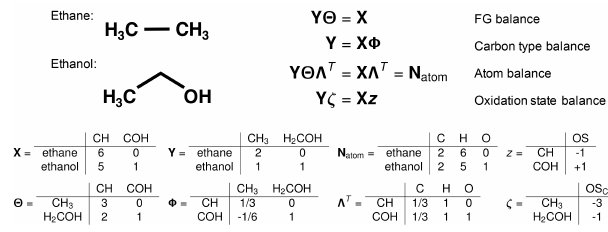
Figure 1. Illustration of carbon type and FG relationships for ethane and ethanol. The FG composition matrix ( X ), carbon type matrix ( Y ), and atom composition matrix ( A ) describe properties of the compounds, and the remaining arrays – oxidation state contribution vector ( z ), carbon–FG matrix ( (cid:50) ), FG–carbon matrix ( (cid:56) ), atom– FG matrix ( (cid:51) ), and carbon oxidation state vector ( ζ ) – establish their inter-relationships.